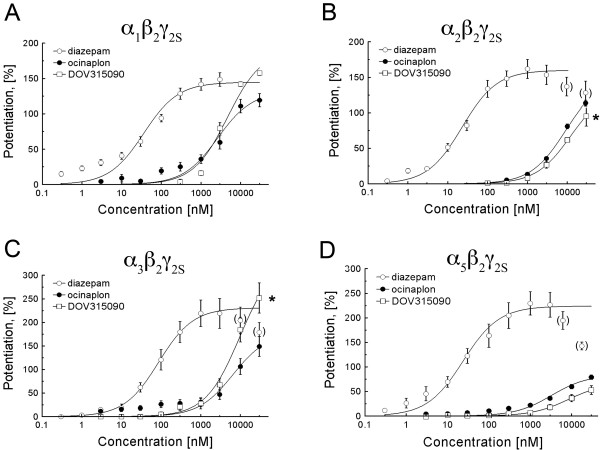
Potentiation of GABA-gated currents by diazepam, ocinaplon and DOV 315,090. Rat GABAA-Rs consisting of α1β2γ2S, α2β2γ2S, α3β2γ2S and α5β2γ2S subunits were expressed in Xenopus oocytes. Potentiation was determined using an EC10 concentration of GABA (~10 μM for α1β2γ2S, α2β2γ2S and α3β2γ2S; ~5 μM for the α5β2γ2S). Curves were calculated by normalizing values of relative currents obtained following administration of diazepam (○), ocinaplon (●) or DOV 315,090 (□) in the presence of GABA (from at least four oocytes harvested from at least two batches) to the value obtained following application of GABA. The dose-response curves of diazepam were fitted up to 3 μM. Higher concentrations (in parentheses) were excluded from the fit due to a decline in potentiation at higher concentrations. Smooth curves are calculated based on mean parameter values given in Table 2. Asterisks indicate fits for which the extrapolated Emax is more than 25% greater than the maximum potentiation observed at highest drug concentration.